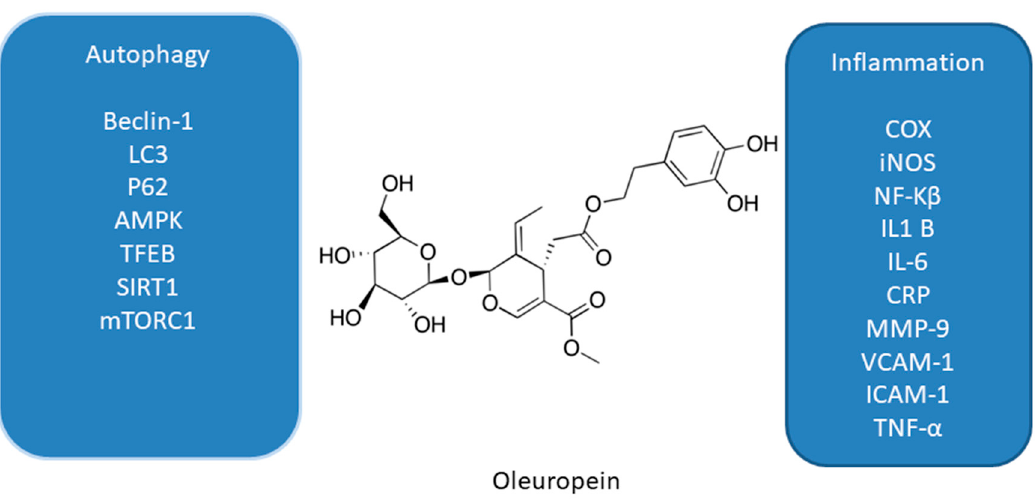
Figure 2. Effect of oleuropein on interplay between autophagy and inflammation [58–65].